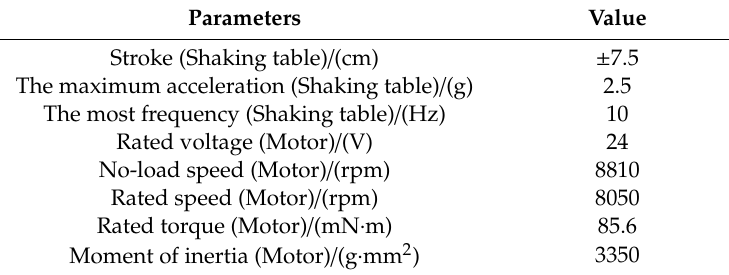
Table 2. Parameters of the experimental